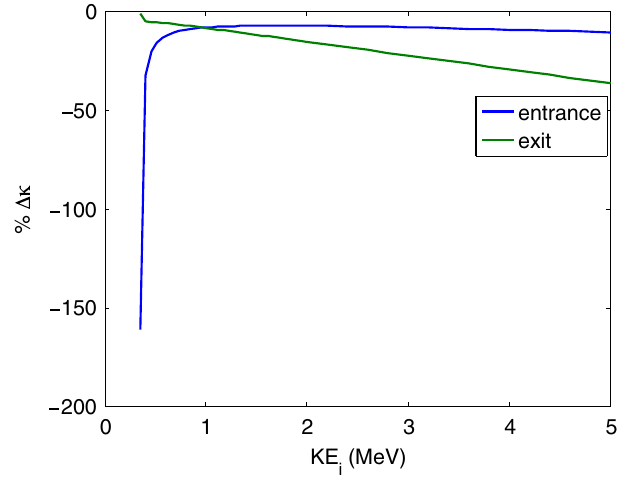
FIG. 11. (cid:3)(cid:1) as a function of initial beam energy with the coupler at the cavity entrance (blue) and exit